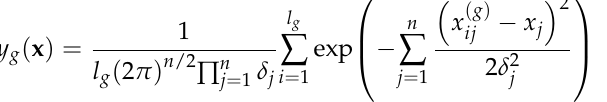
( ) LCE M t is the input at time t for the is the output at time t +1 and in BPNN algorithm. H (·) denotes the function for lane-changing execution process. v S_LD and v S_LT represent respectively longitudinal and lateral speeds of the subject vehicle. Δ v L and Δ v F denote speed differences between the subject vehicle and the leader and follower ve- hicles in the target gap, respectively. d L and d F are distances between the subject vehicle and two adjacent vehicles in the target gap. d Lane is the lateral distance to the target lane for the subject vehicle. Specifically, it denotes the minimum distance between the middle point of vehicle’s front bumper and the centerline of the target lane.